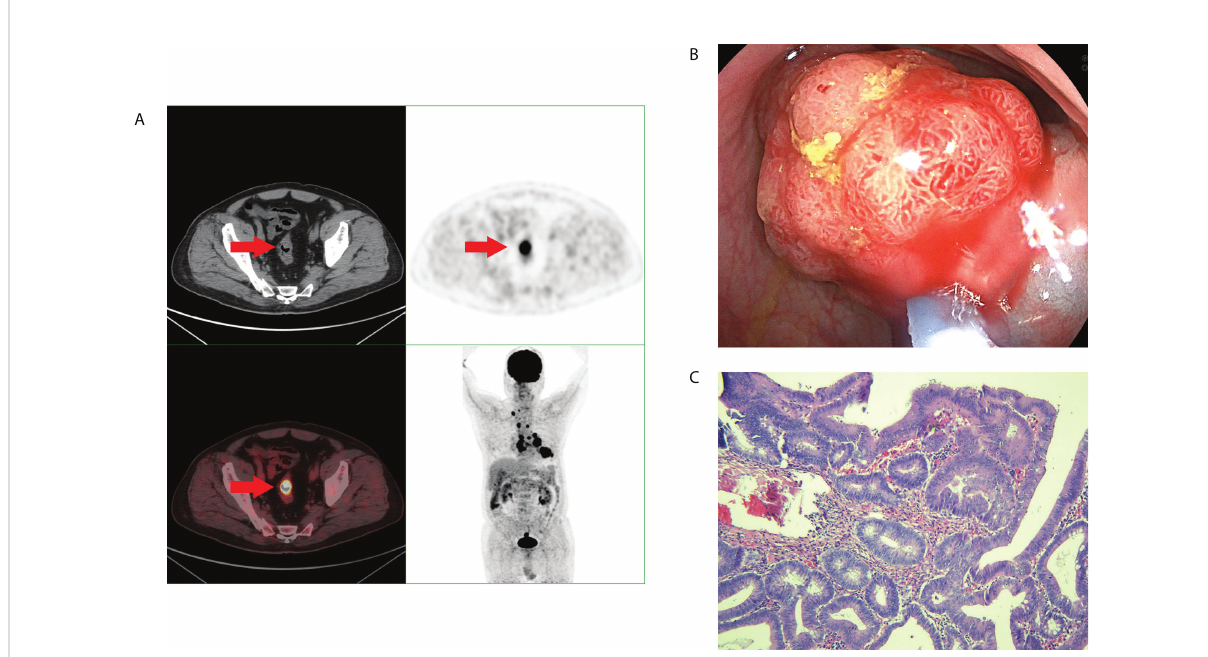
FIGURE 2 A middle-aged man underwent 18F-FDG PET/CT for left lung squamous cell carcinoma. Incidental focal 18F-FDG uptake was found in thesigmoid colon. The patient underwent colonoscopy and pathology examination. (A) Abnormal 18F-FDG PET/CT uptake in the sigmoid colon. (B) shows a sigmoid colonpolyp with a diameter of 2.5 cm. (C) shows the pathological pattern of villous tubular adenoma with high-grade intraepithelial